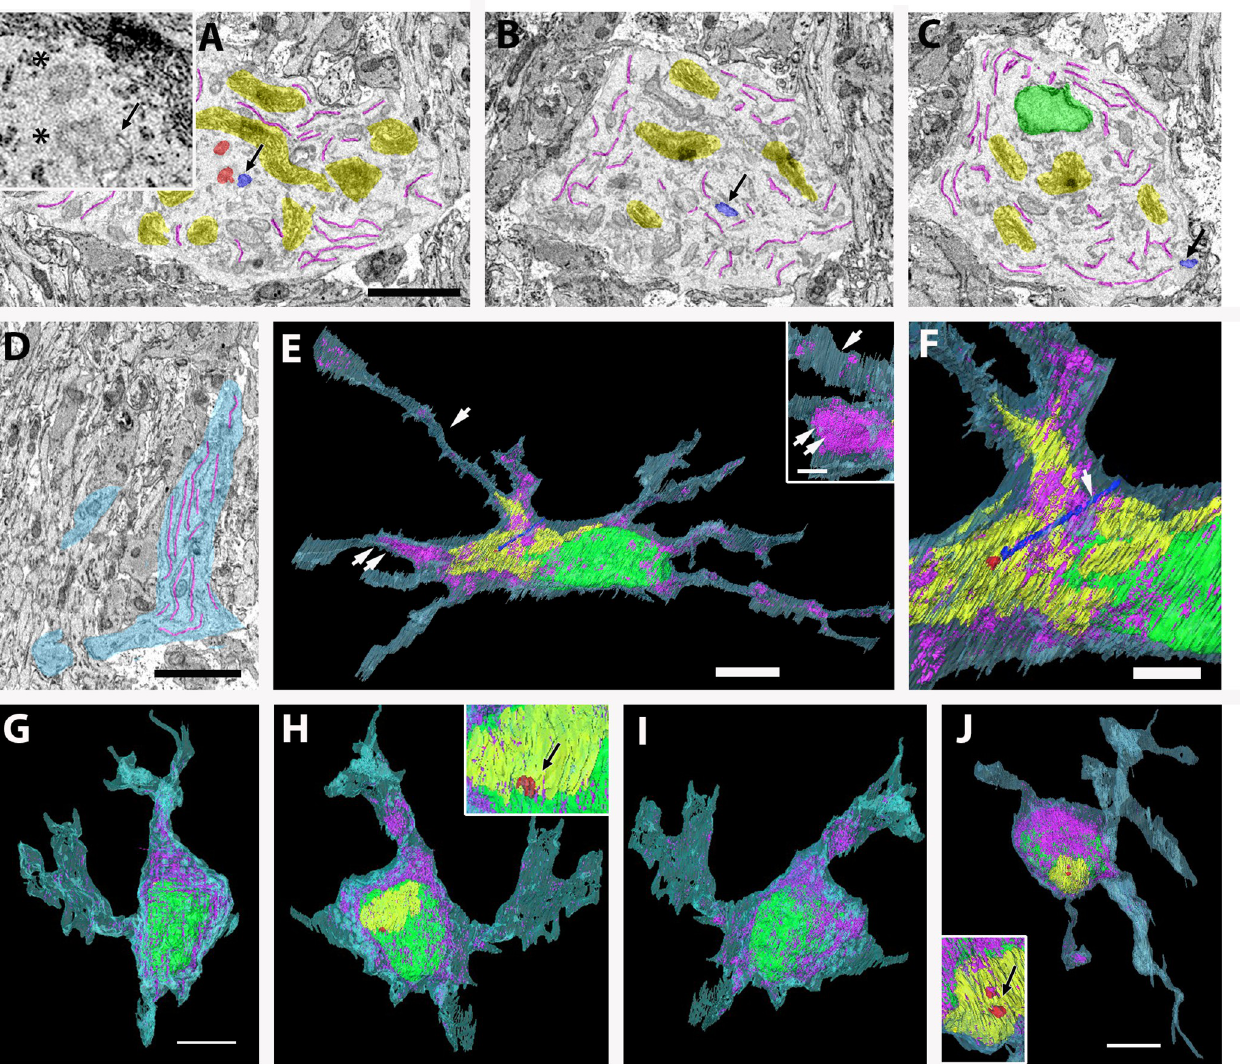
Fig 3. Fine structure and 3D reconstruction of astrocytes and microglia. (A–F) Astrocyte shown in Fig 1B. (A–C) To show the cilium clearly, the cytoplasm is colored in white, centrioles (basal bodies) in red, and the cilium in blue (arrows). Centrioles (asterisks) and the base of cilia are magnified in inset A. Note that the cilium shows a ciliary pocket. (D) ER in the proximal process. In this image, cytoplasm is colored in light blue. (E, F) A 3D reconstruction demonstrates that this cell extends 9–10 processes. Processes indicated by arrows are magnified in the inset at a different angle. Note that most processes are a flattened shape rather than cylindrical (compare E with the inset in E). Double arrows indicate an approximate region of cut plane in D. (F) Higher magnification image of the 3D reconstruction of the cilium (arrow). (G–J) 3D reconstructions of two microglia. (G–I) The microglia shown in Fig 1D contain lamellipodia at the process tips. The nucleus shows a disk shape, and ER are localized on one side of the cytoplasm. The inset in H shows a pair of centrioles closely associated with the Golgi apparatus. (J) The other microglia extend several processes without lamellipodia. The inset shows a higher magnification image of a pair of centrioles (red) closely positioned to the Golgi apparatus. Bars = 2 μ m in A, D, F, and the inset in E, and 5 μ m in E, G, and J.